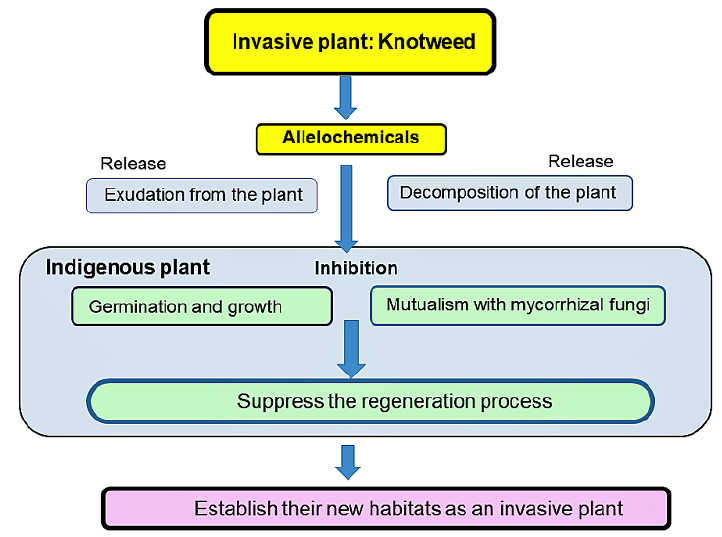
Figure 3. A possible scheme of knotweed to establish the new habitats.